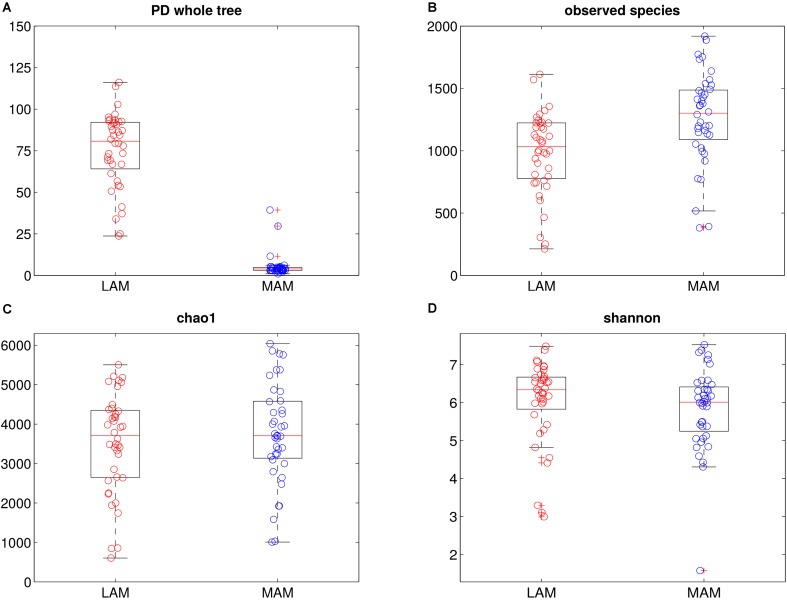
Intra-samples diversity of LAM and MAM microbiota. Boxplots of end-point α-diversity of LAM and MAM samples according to Faith’s phylogenetic diversity (A), observed species (B), chao1 (C) and Shannon (D) indexes. MAM samples (blue) have significantly lower values than LAM (p = 0.001, red) for Faith’s phylogenetic diversity metric, whereas, show a significantly higher number of observed species (p = 0.001).